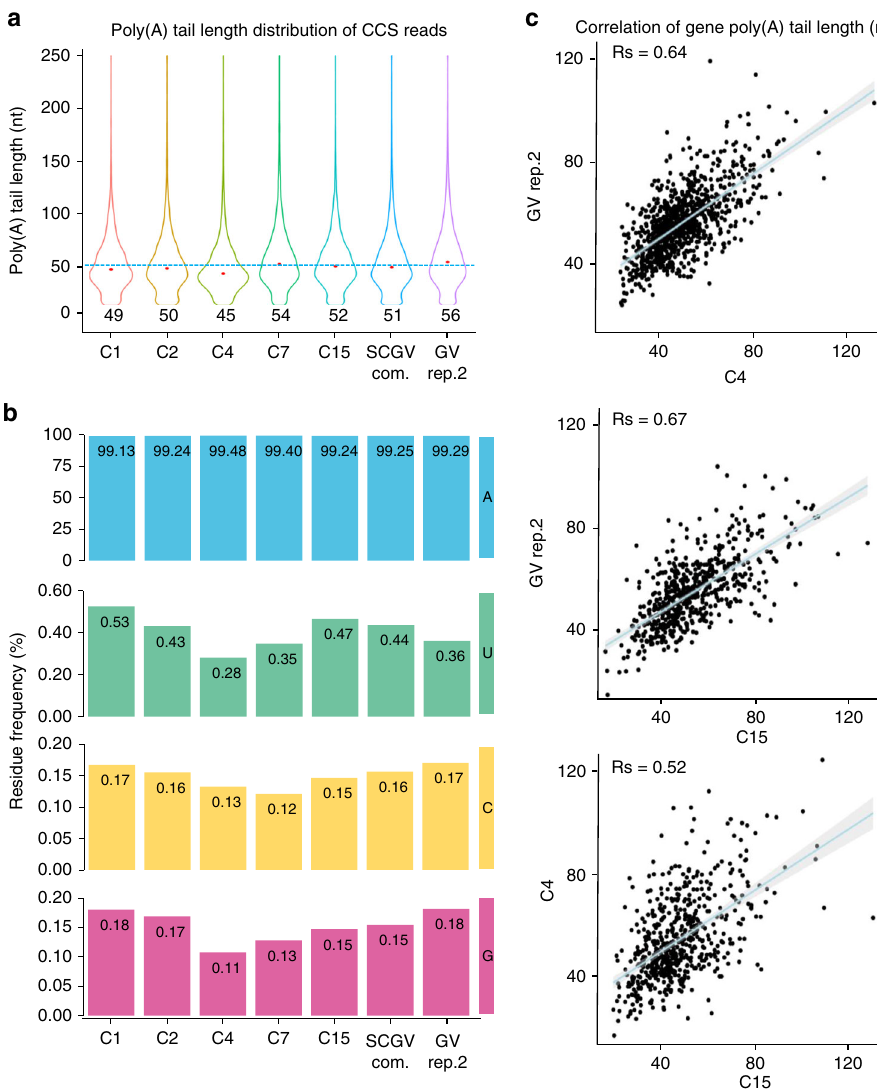
Fig. 6 Single-cell PAIso − seq for GV oocytes. a Global poly(A) tail length distributions of all detected CCS reads (Pass ≥ 10) in single GV oocyte C1 (cell 1), C2, C4, C7, C15, and GV rep.2, and single GV oocyte-combined (SCGV com.) datasets. The median length of each poly(A) tail of a transcript is shown as the red dot and the number below the violin plot. b The frequency of non-A residues in single GV oocytes C1, C2, C4, C7, C15, GV rep.2, and SCGV com. datasets. c The Spearman ’ s correlation of gene poly(A) tail length between single GV oocyte C4 and GV rep.2 (top panel, n = 928), single GV oocyte C15 and GV rep.2 (middle panel, n = 566), single GV oocyte C15 and C4 datasets (bottom panel, n = 597) datasets. The blue line represents linear regression line. The light-gray area represents con fi dence interval of the regression. Genes with at least four transcripts in each of the datasets are included in the